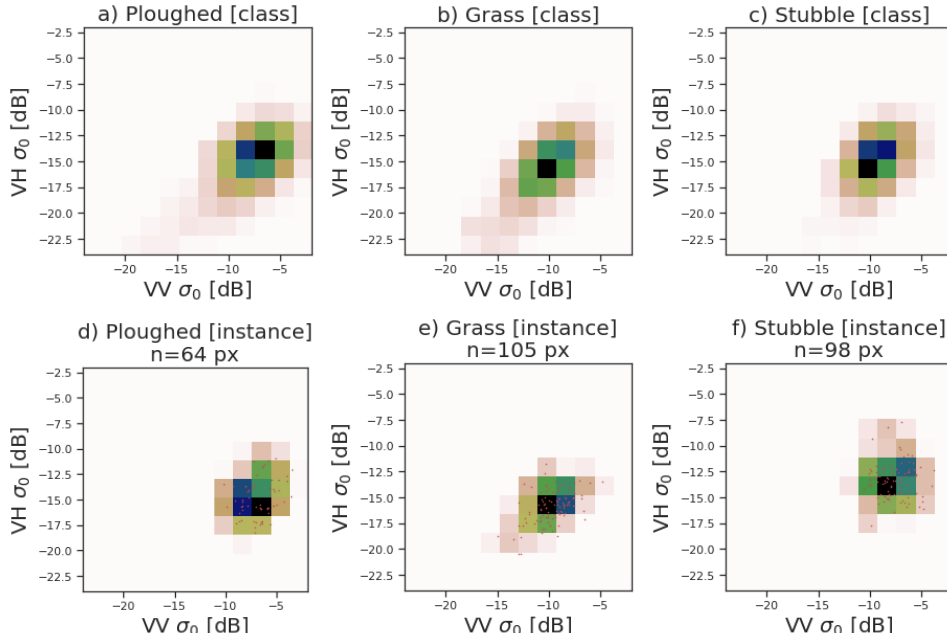
Figure 4. Gaussian kernel density estimate representations of polarimetric SAR intensity measure- ments for ploughed, grass- and stubble-covered fields. ( a – c ): Class-level density estimates from a large random sample of all pixels of all field parcels of a class. ( d – f ): Density estimates for single parcels of each class. The small red dots indicate individual pixels, with small jitter so multiple pixels with identical values are also visible.